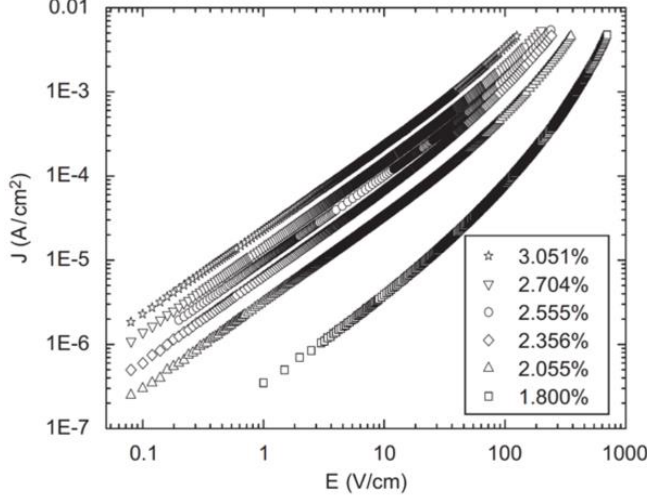
Figure 26. Current density ( J ) vs. electric field ( E ) for GNs/epoxy composites with different filler contents. Reprinted from [73], Copyright 2007, with permission from Elsevier. Table 8. Switching field for GNs/epoxy composites [73]. GN